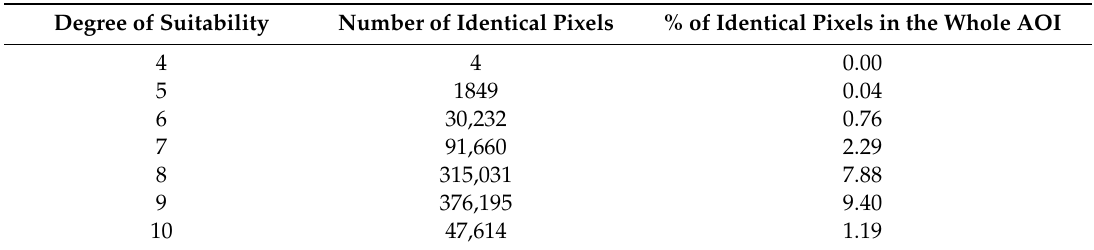
Table 4. The number of identical pixels in the intersection of all MCA methods used and their percentage.